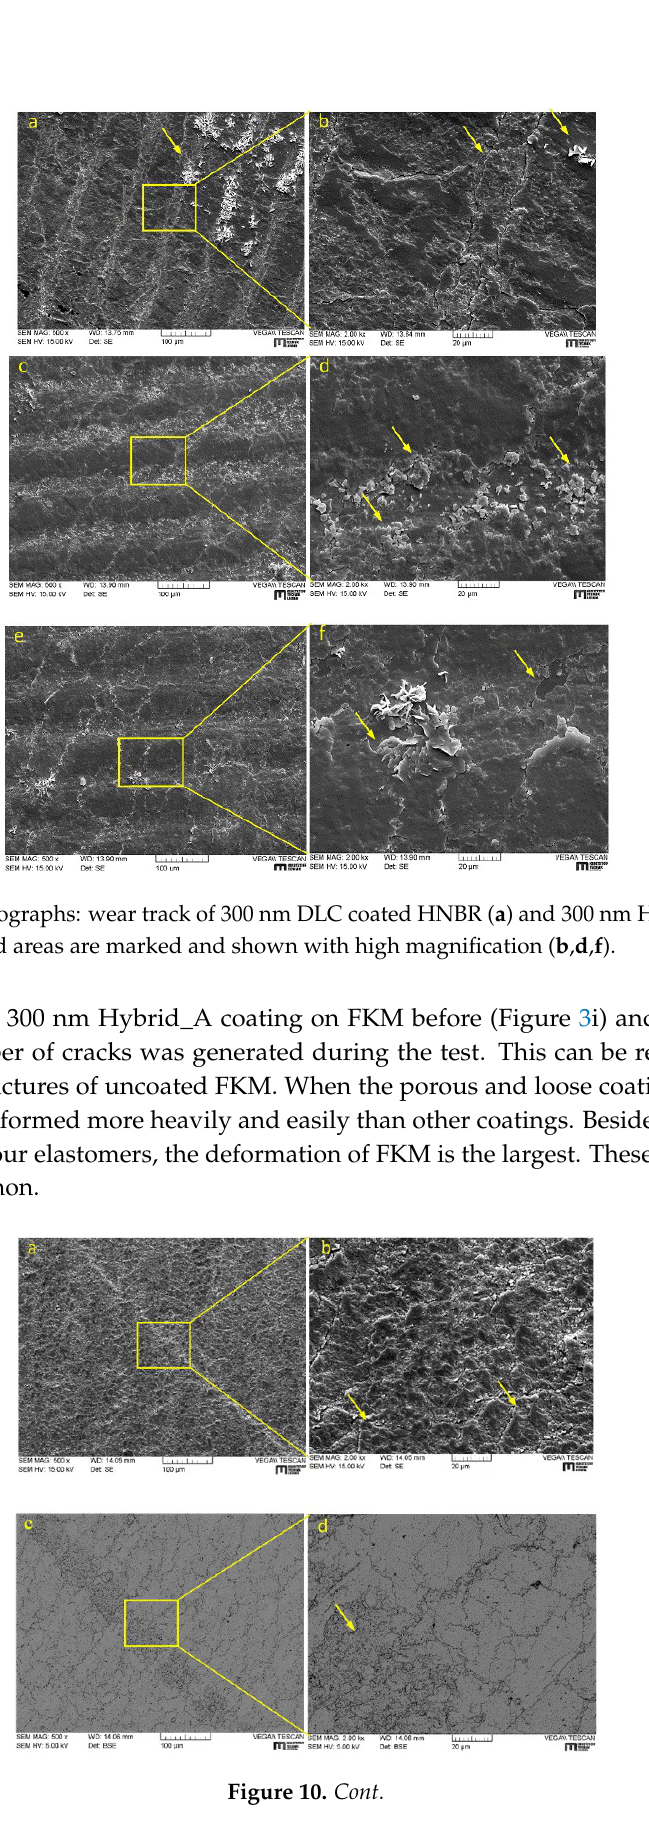
generated through dynamic motion in crack area. All of these particles were collected during the test